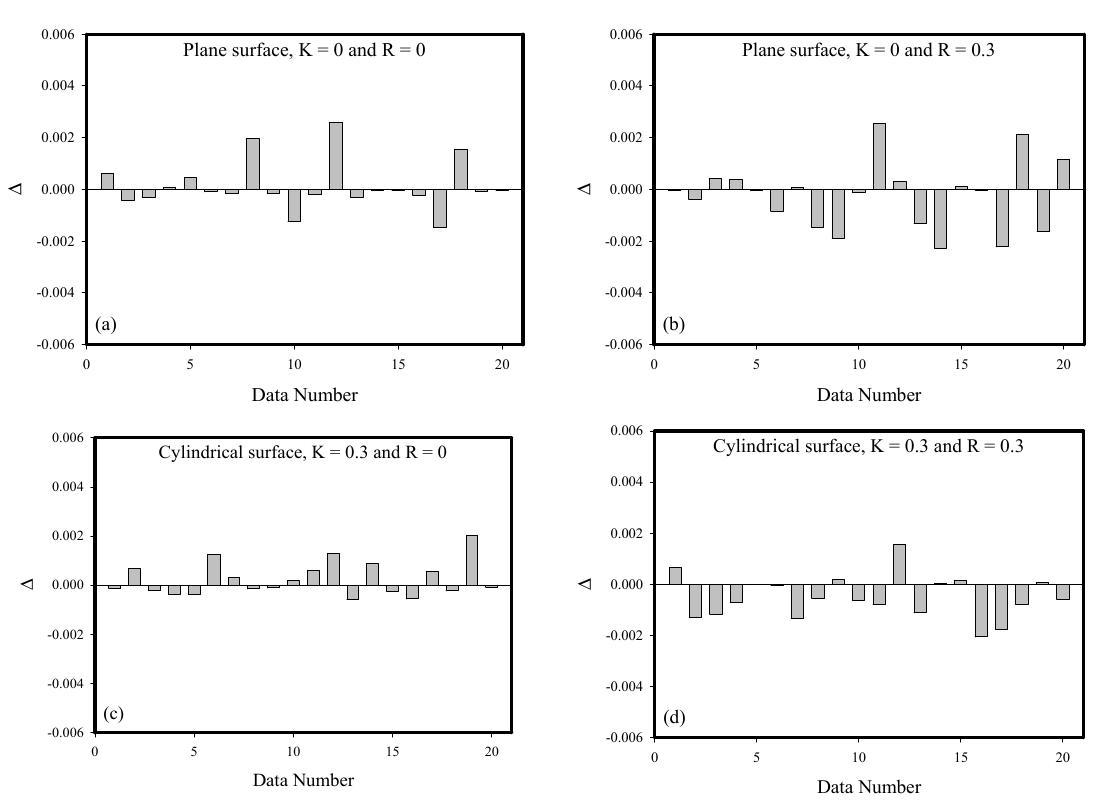
Figure 10. The differences between the target values and the outputs of the ANN model for thermal Flow Regimes-I ( a ), -II ( b ), -III ( c ), and -IV ( d ).